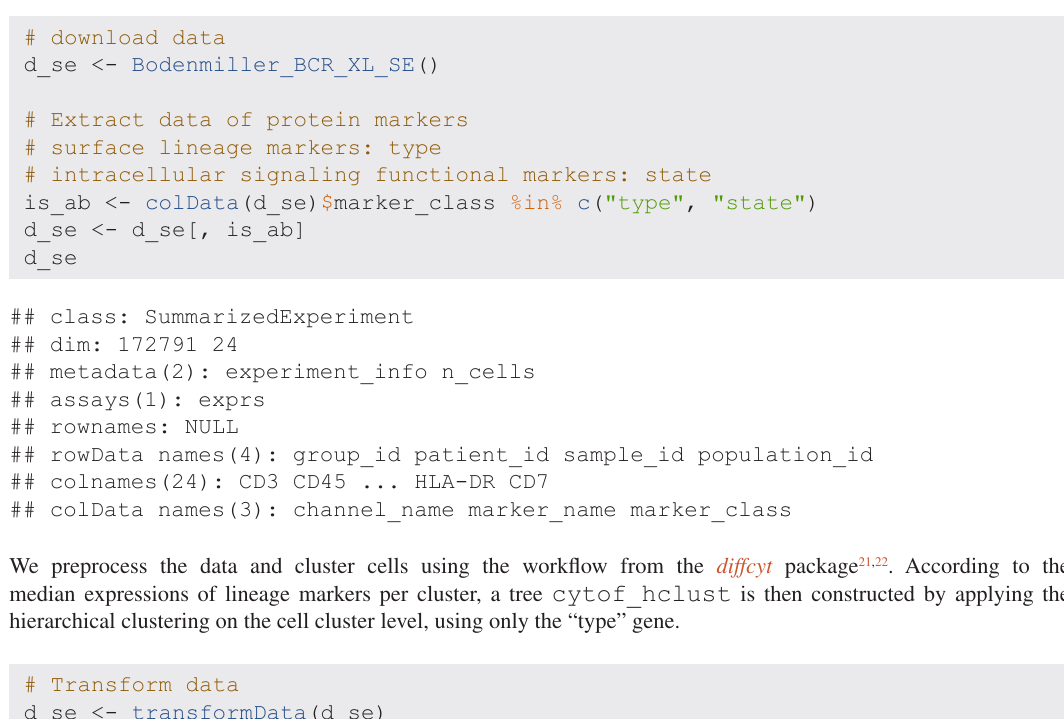
one unstimulated sample, and one sample stimulated with B cell receptor/Fc receptor cross-linker (BCR-XL). The data contains expressions of 24 protein markers: 10 surface lineage markers (type) and 14 intracellular signaling functional markers (state) , from 172791 cells.